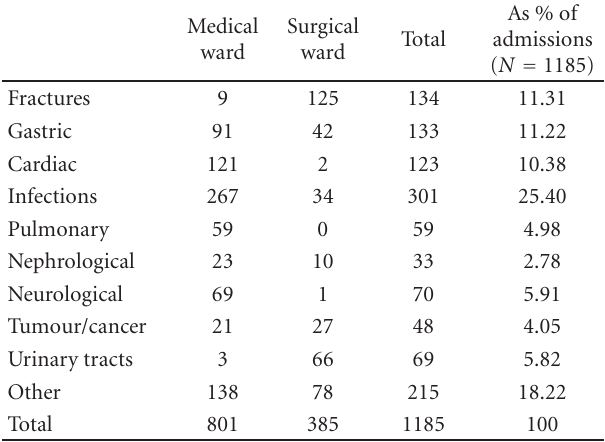
Table 2: The generic groups for admissions to medical and surgical wards from nursing homes in the city of Bergen, Norway, from March 2006 to March 2007 ( N = 1185 with diagnosis).